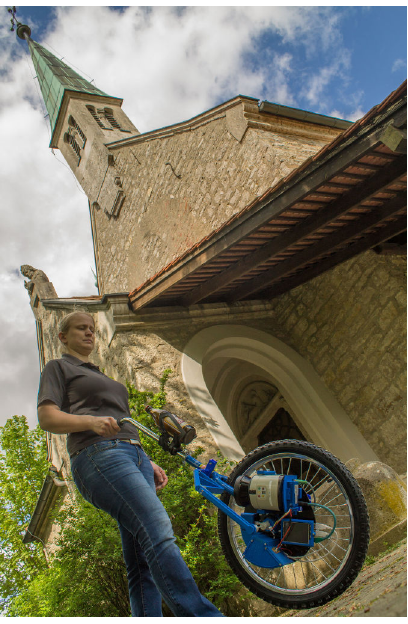
Figure 1. First author operating RADLER 1 (RADial LasER scanning